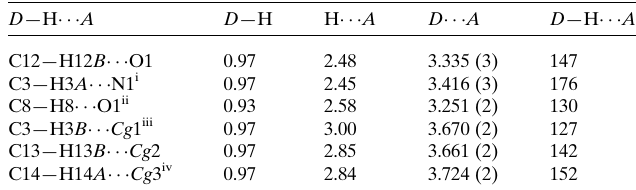
Table 1 Hydrogen-bond geometry (A˚ , (cid:2) ).